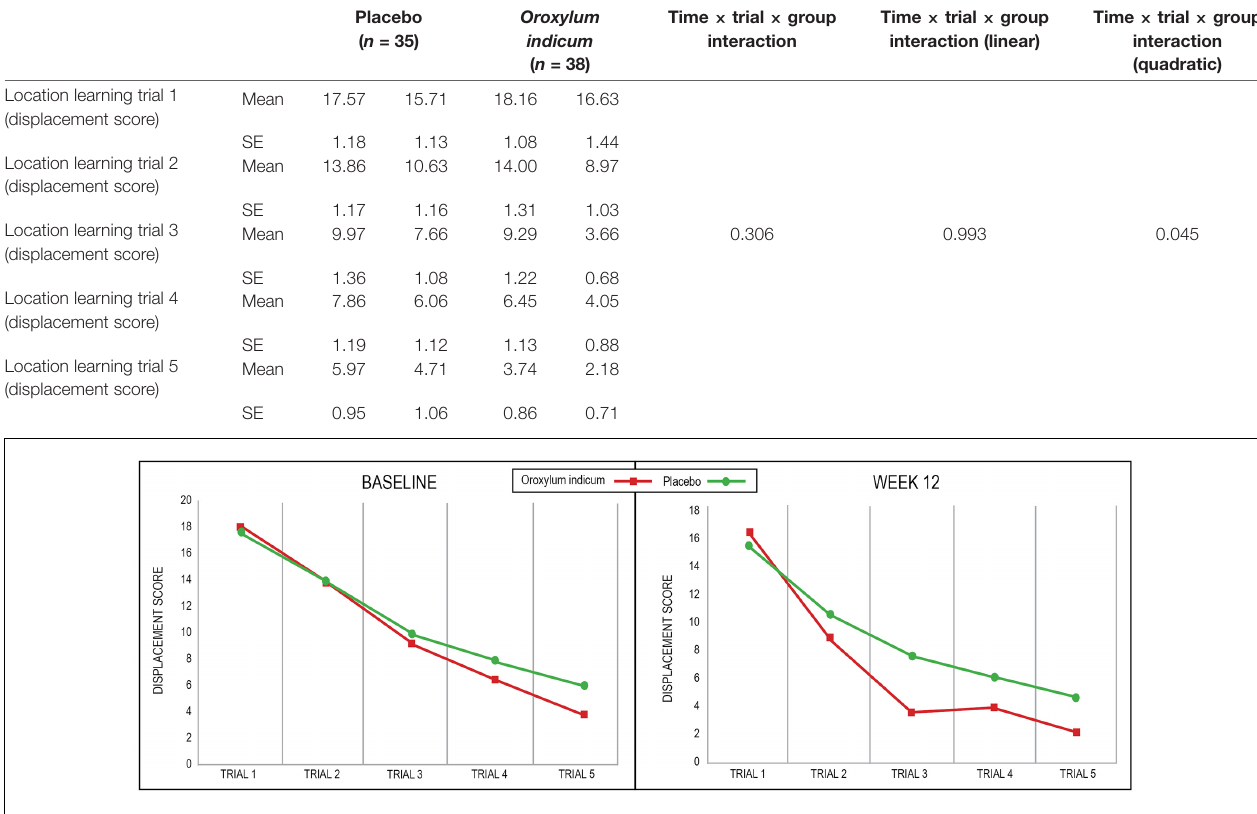
FIGURE 2 | Displacement scores in the COMPASS location learning